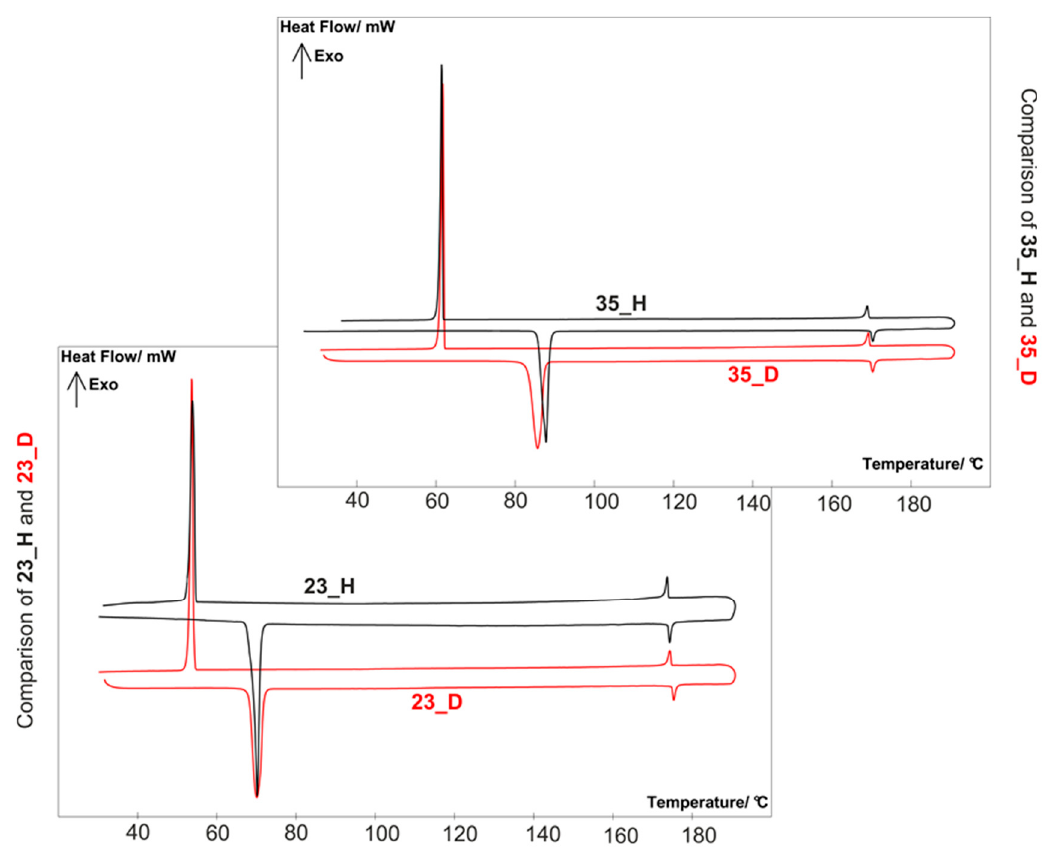
Figure 3. Comparison of DSC of selected hydrogen and deuterated